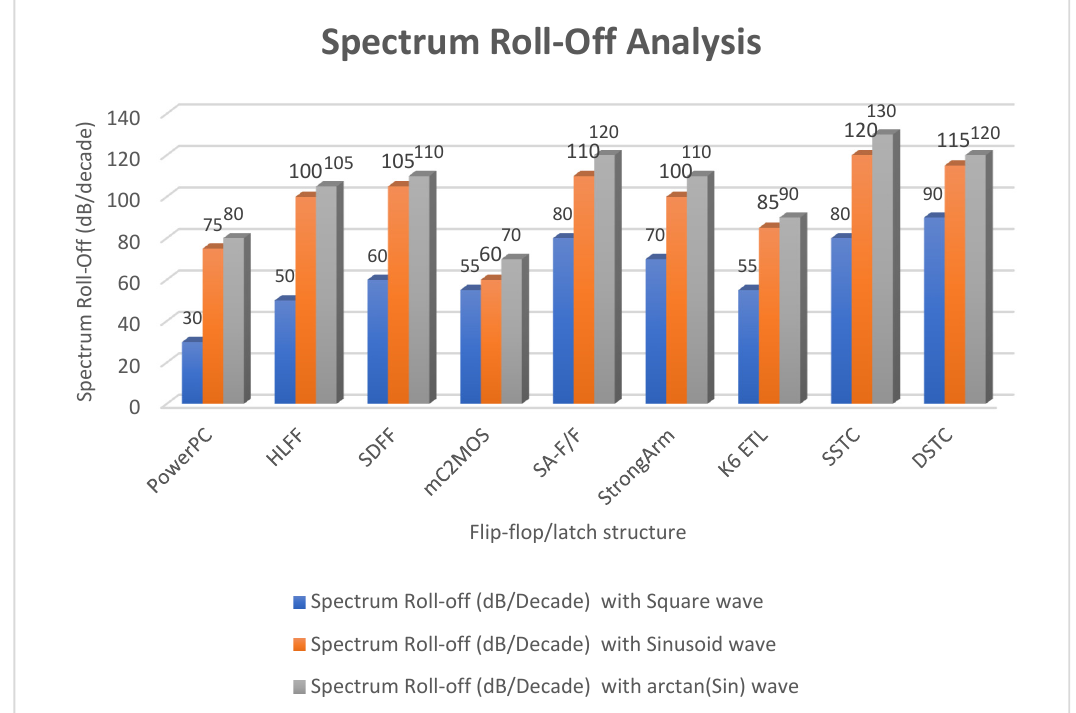
Figure 13. Spectrum roll-off analysis using 130 nm process technology and various types of input signals.